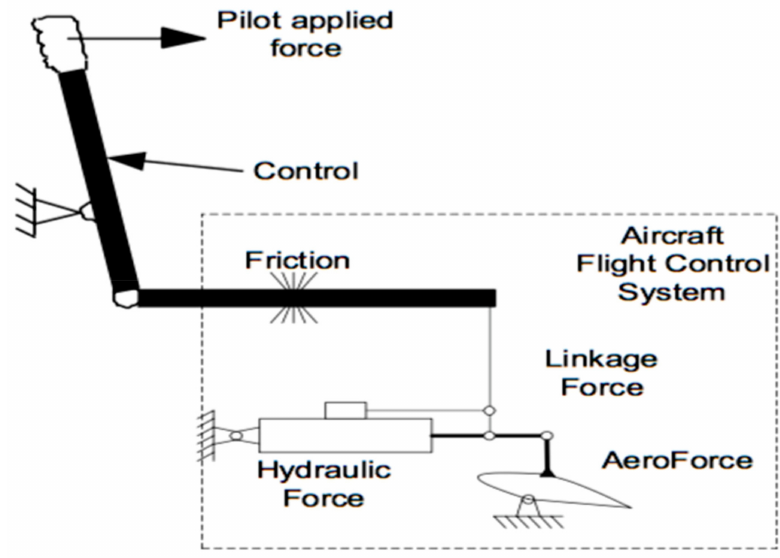
Figure 3. A mechanical/hydraulic FCAS